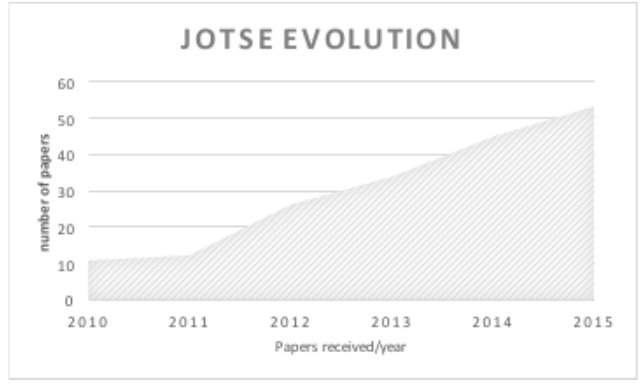
Figure 1. JOTSE's